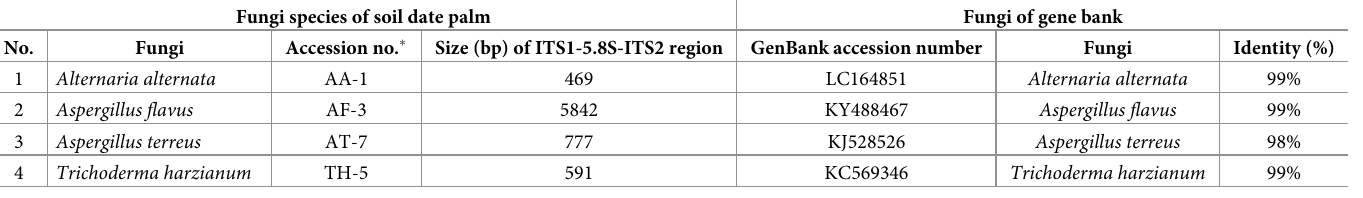
Table 2. Identification of fungi species isolated from rhizosphere soil by sequencing of ITS1 and ITS 2 and region of 5.8S rRNA gene compared with sequences listed in the GenBank.